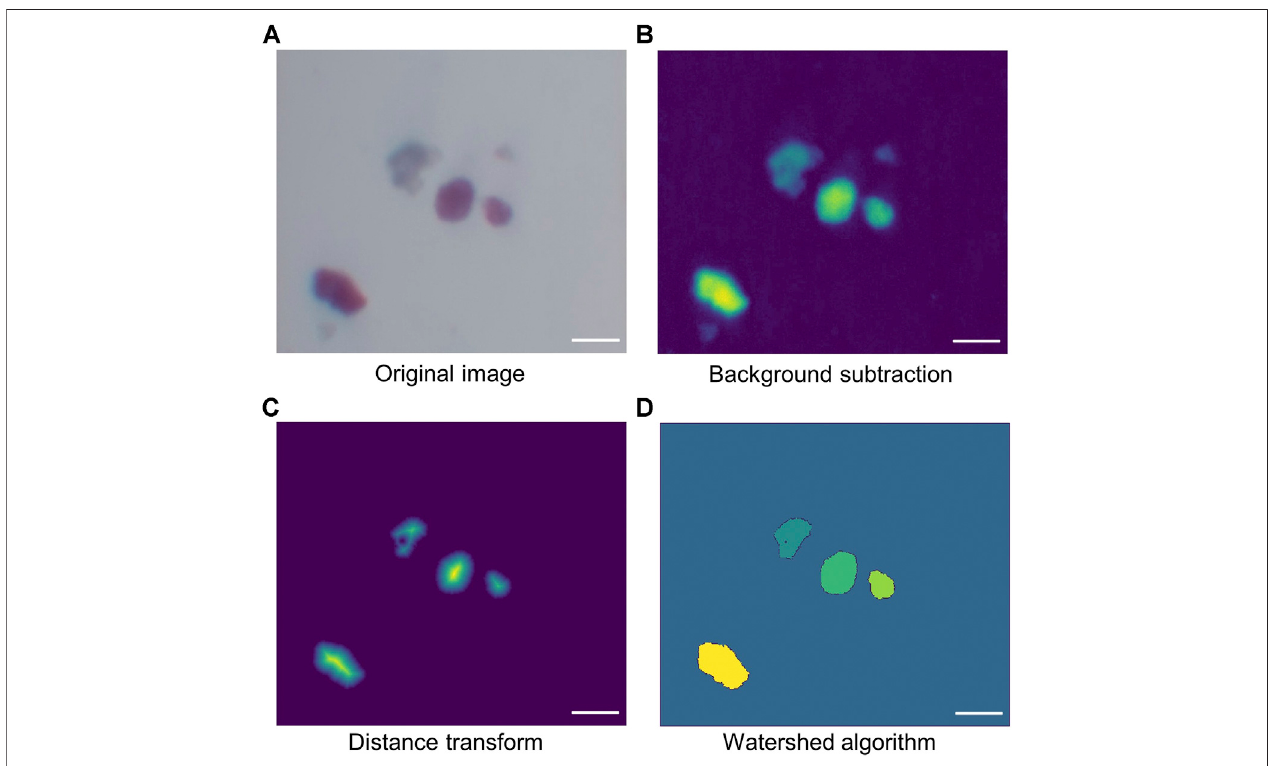
FIGURE 3 | Demonstration of cell segmentation. (A) Original image directly obtained from the smartphone camera. (B) Image created by subtracting background fromtheoriginalimage. (C) Imageafterapplyingdistancetransform.Sincedistancetransform calculatesthedistanceofeachpixelfromitsnearestboundary,thecentral pixels have higher values. As a result, when applying the proper threshold to the transformed image, small-sized cells as well as peripheral areas of large cells (mainly connections between cells) can be removed, leaving only the central area of large cells. (D) Image created by watershed algorithm. Scale bar (cid:1) 200